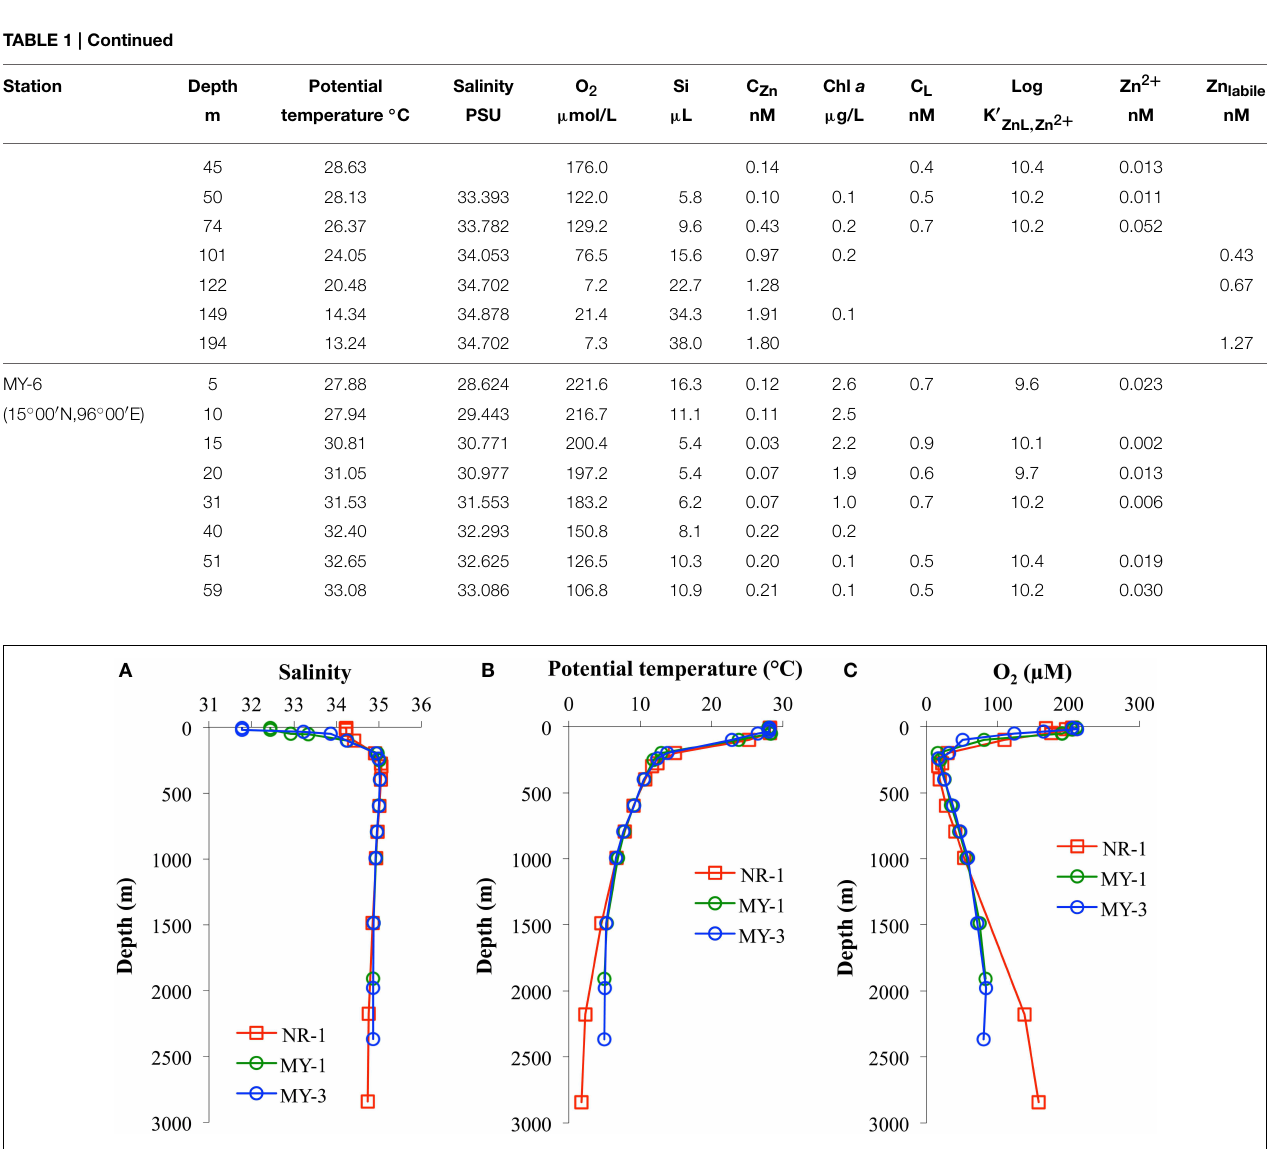
FIGURE 3 | The vertical profiles of (A) salinity, (B) potential temperature, and (C) dissolved O 2 in the northeastern Indian Ocean (NR-1) and the Andaman Sea (MY-1 and MY-3).